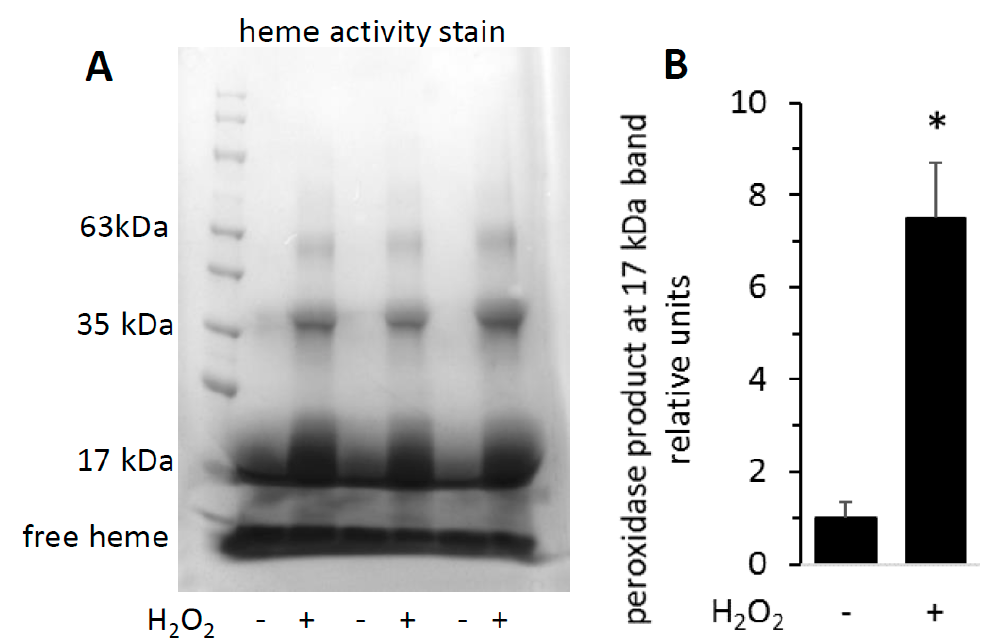
Figure 3. Reaction of metMb with H 2 O 2 increases peroxidase activity as visualized on polyacrylamide gels. metMb (555 µM, pH 5.9) was incubated in the absence or presence of 800 µM H 2 O 2 for 15 min before performing SDS-PAGE and ( A ) heme-peroxidase activity stains (right) as described in methods. ( B ) Quantitation of the peroxidase product at the 17 kDa band, n = 3/group, * p < 0.01.